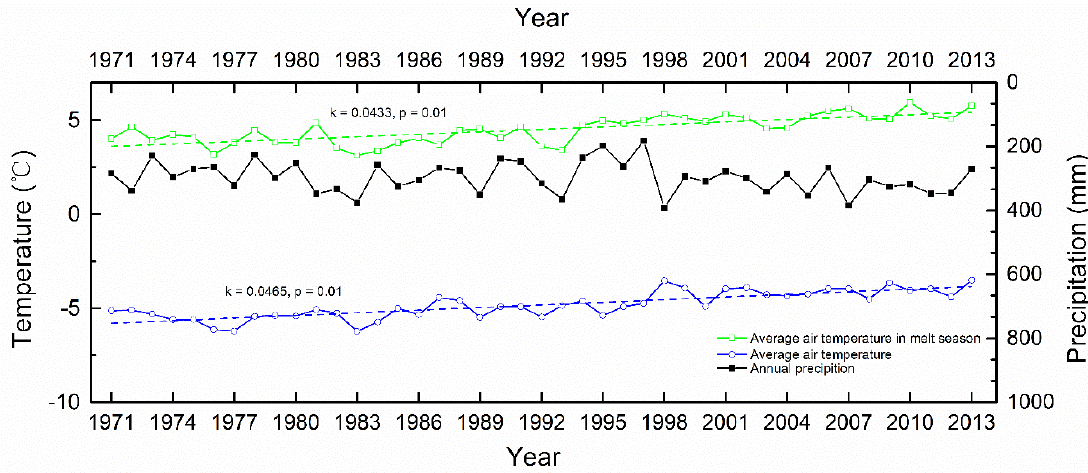
Figure 8. Annual average air temperature (°C), average air temperature in melt season (°C), and annual precipitation (mm) in the URSRB during 1971 to 2013, where k is the slope of the linear trend, and p is the significance level of the t